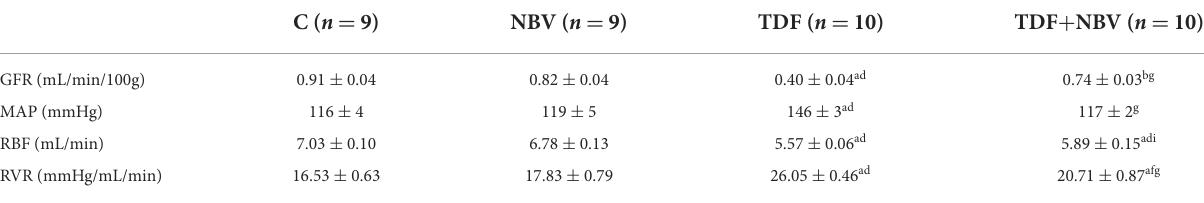
TABLE 1 Renal function and hemodynamic parameters evaluated after the 30-day